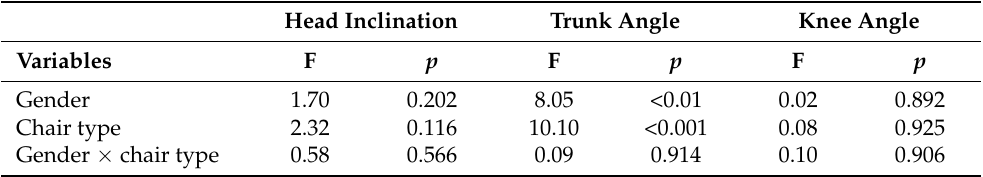
Table 1. Two-way ANOVA results for mean joint angles calculated from 5 repeated trials.